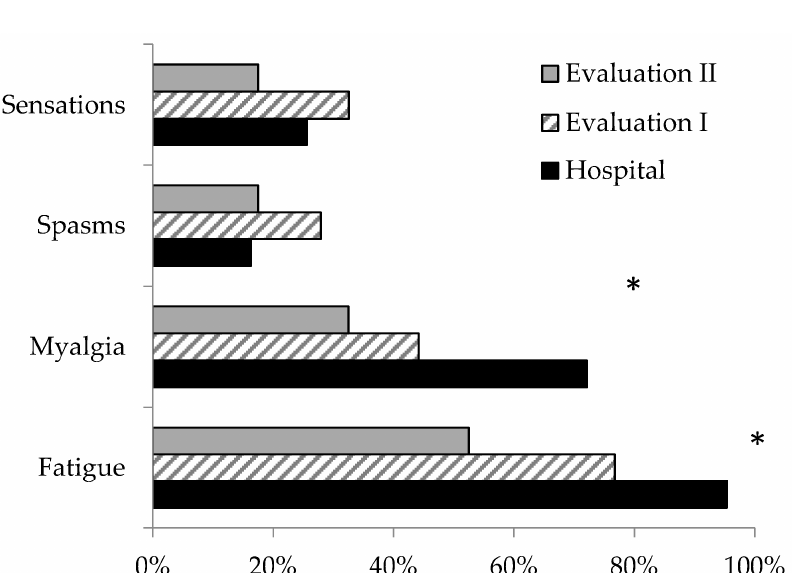
Figure 2. Frequency of symptoms during hospital stay, and two follow-up evaluations of 40 patients with moderate to severe COVID-19. * marked differences are for p < 0.05.